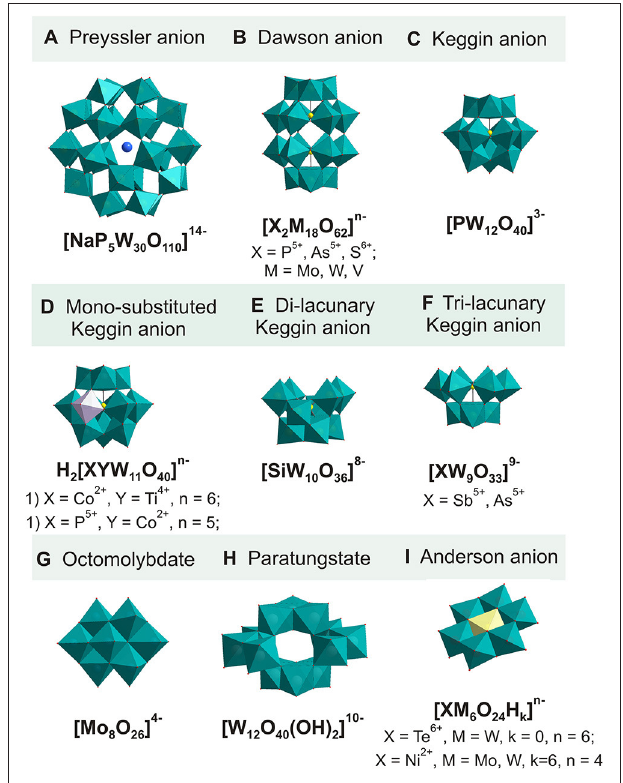
FIGURE 1 | Polyhedral representation of key POM structures tested in this study. (A) Preyssler structure [NaP 5 W 30 O 110 ] 14 − ( Jeannin et al., 2007); (B) Dawson structure [ X 2 M 18 O 62 ] n − (X = P 5 + , As 5 + , S 6 + ; M = Mo, W, V) (e.g., Contant et al., 2007); (C) α -Keggin structure [PW 12 O 40 ] 3 −